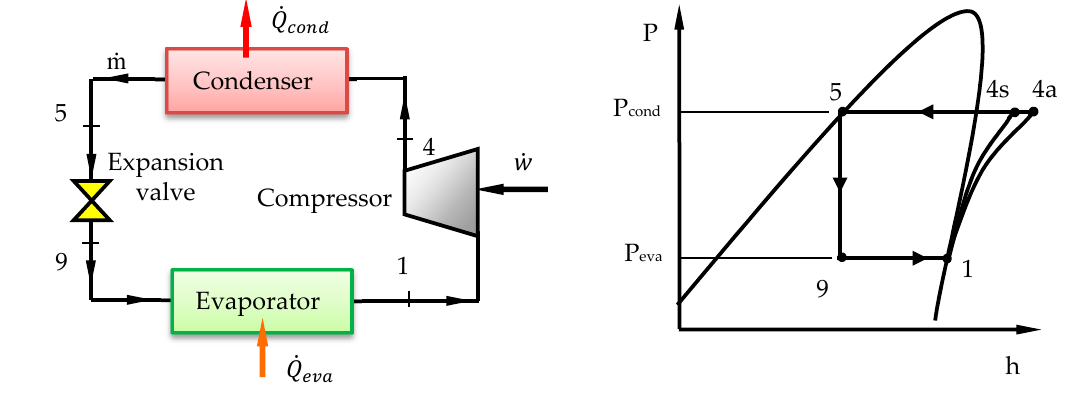
Figure 1. Schematic diagram of the VCRC and its P-h diagram.